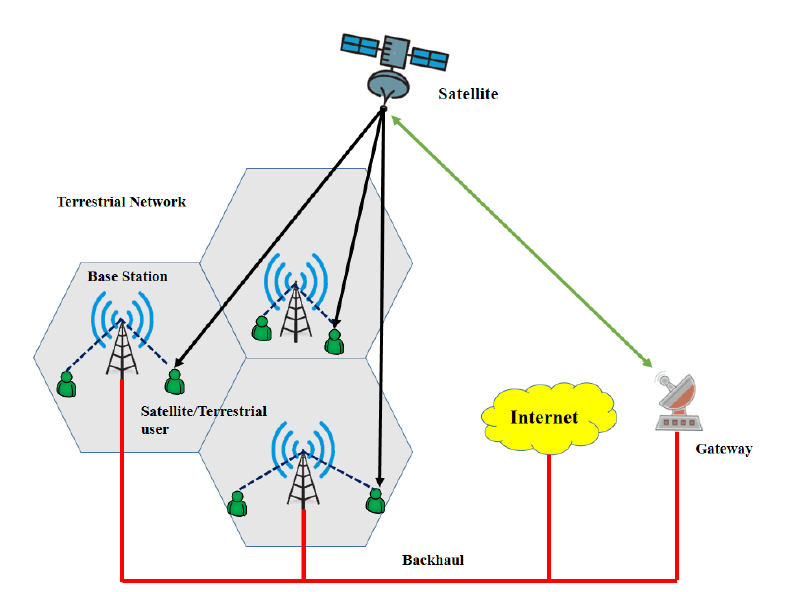
Figure 2. Coordinated HSTN.